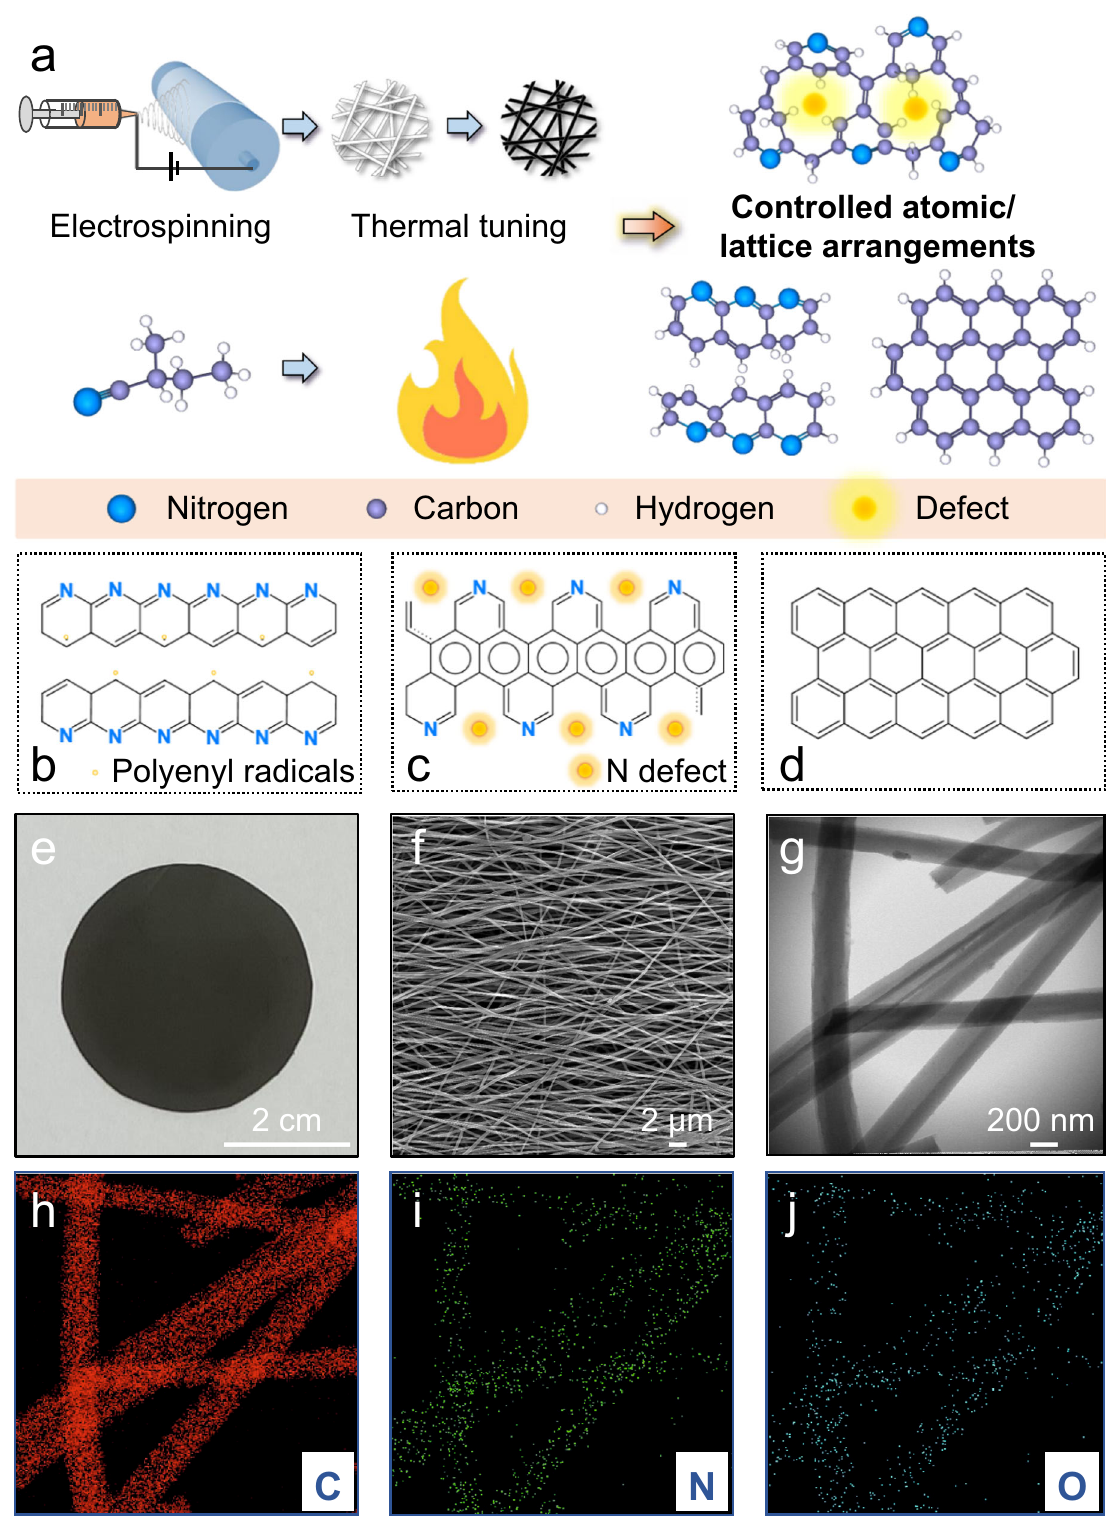
Fig. 1 | Facile temperature control enables fi ne-tuning of atomic/lattice arrangements. a Schematic protocol of preparation of N-doped carbon nano fi ber (CN) membranes and an illustration of the thermal tuning process. Illustrations of the molecular structures of the prepared CNs corresponding to different thermal